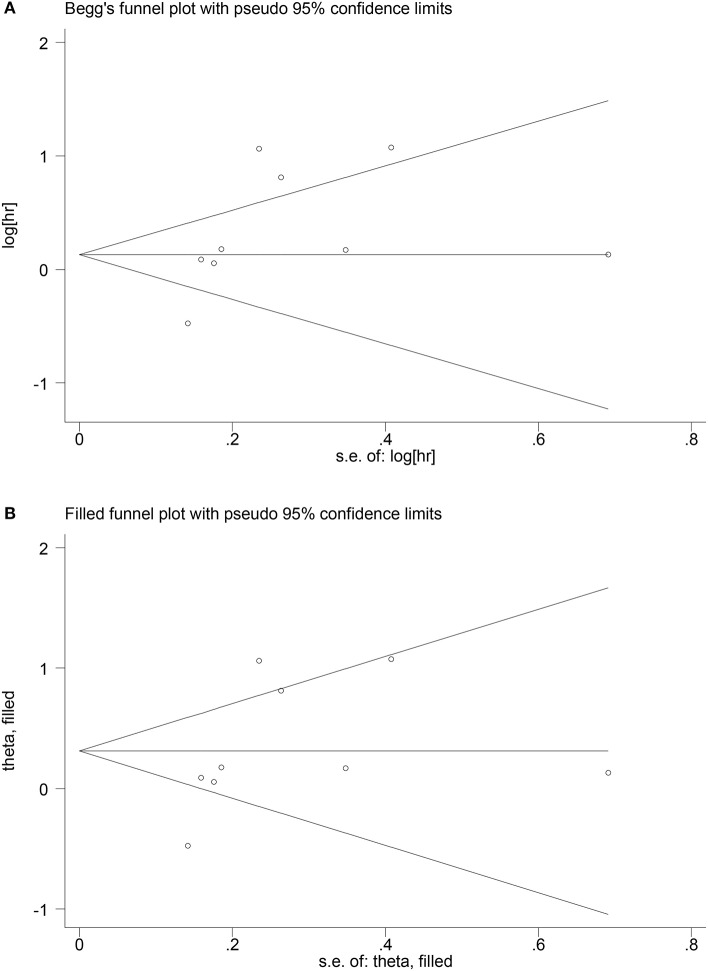
Begg's funnel plot of publication bias for OS (A); adjusted Begg's funnel plot from trim-and-fill analysis for HR for OS in EC patients (B).